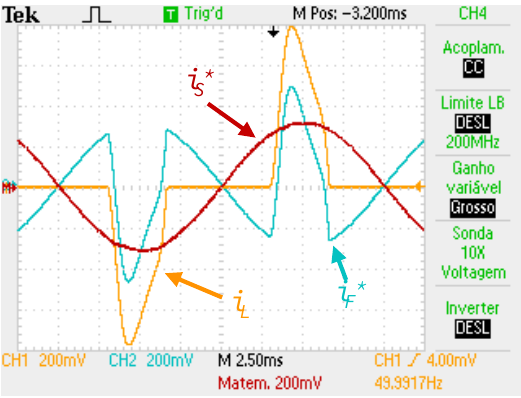
Figure 23. Validation of the p - q theory algorithm with a full-bridge diode rectifier: Load current ( i L ), compensation current calculated by the p - q theory ( i F *), and the theoretical source current after the compensation ( i S *).